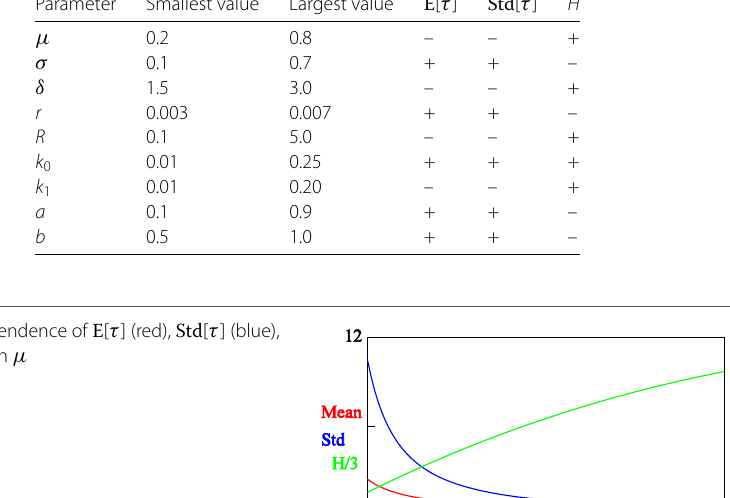
Figure 14 Dependence of E [ τ ] (red), Std [ τ ] (blue), and H (green) on σ